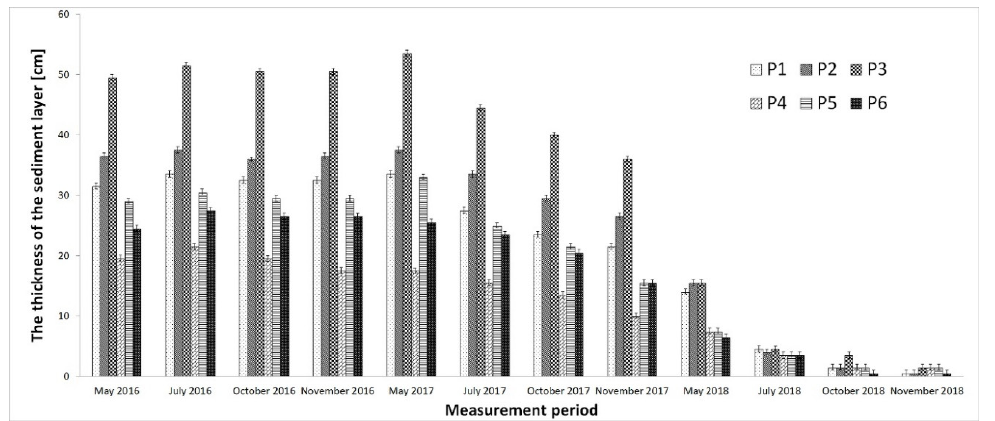
Table 4. Analysis of variance of selected parameters value in the period 2016–2018 (between months).